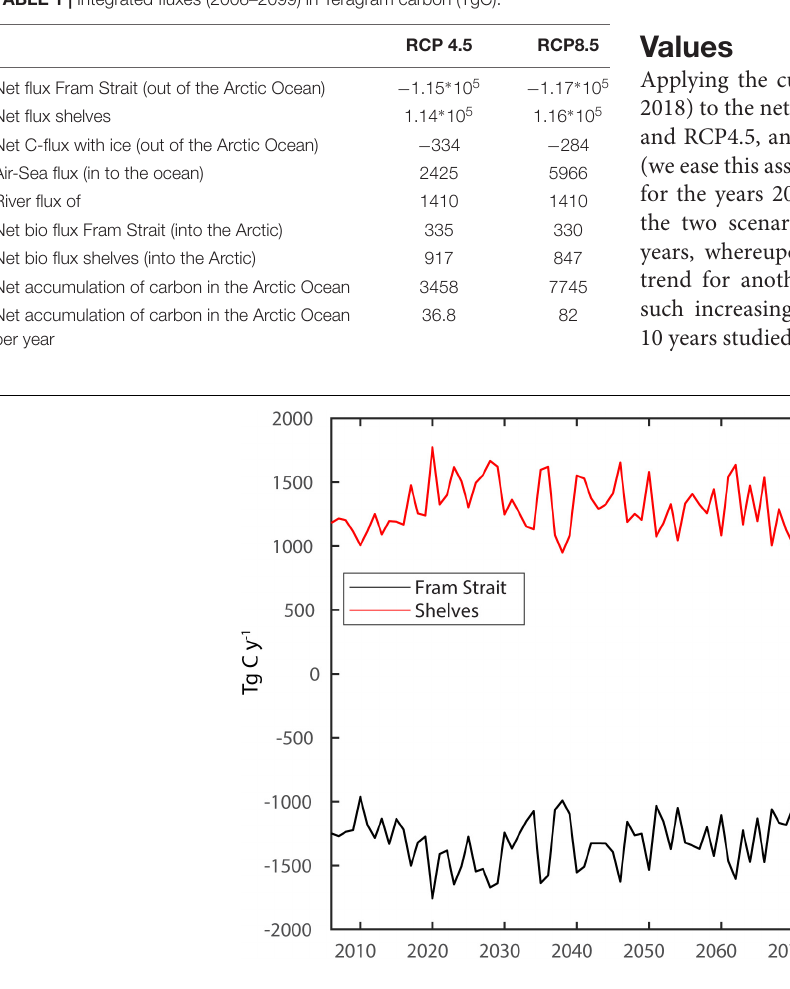
FIGURE 5 | Net annual inorganic C-flux through Fram Strait and the shelves areas for the RCP8.5 scenario.